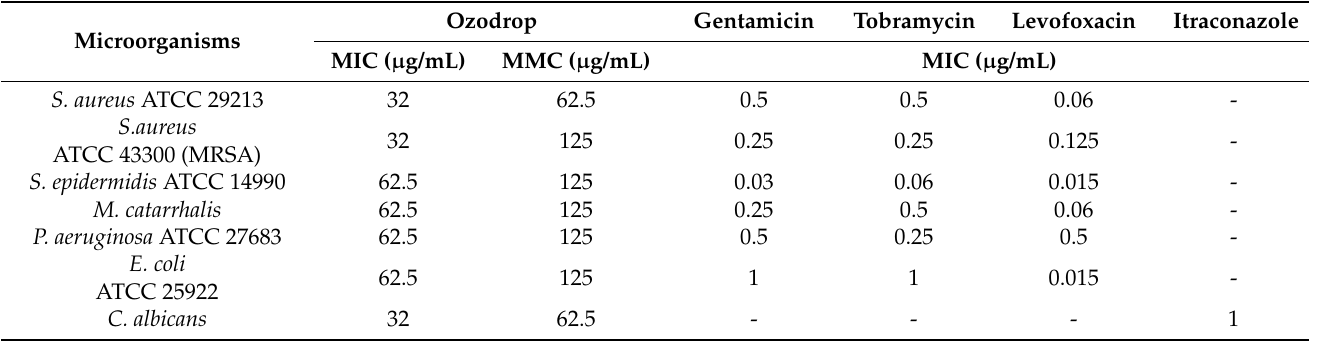
Table 2. Minimum Inhibitory Concentration (MIC) and Minimal Microbial Concentration (MMC) values of ozonized oil in liposomes (Ozodrop ® ) in relation to reference